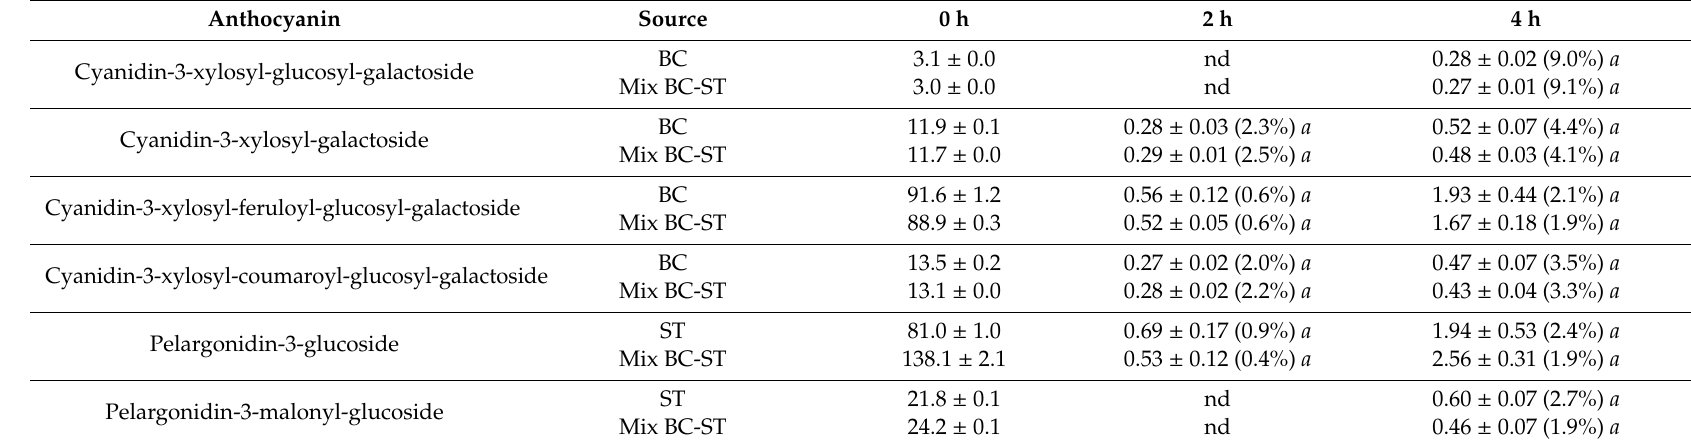
Table 4. Basal side recoveries of black carrot (BC) and strawberry (ST) anthocyanins and their mixture (Mix BC-ST) after 2 and 4 h of administration. Concentration expressed as µ M (mean ± SD) ( n = 3). Values in brackets represents the basal recovery